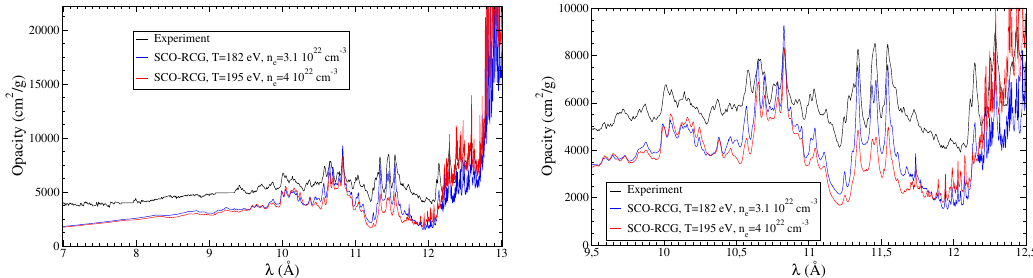
Figure 11. Opacity computed by SCO-RCG in two different conditions: T = 182 eV, n e = 3.1 × 10 22 cm − 3 and T = 195 eV, n e = 4 × 10 22 cm − 3 between 7 and 13 Å ( left ) and focusing on 2 p → 4 d lines in the range [ 9.5 − 12.5 ] Å ( right ).